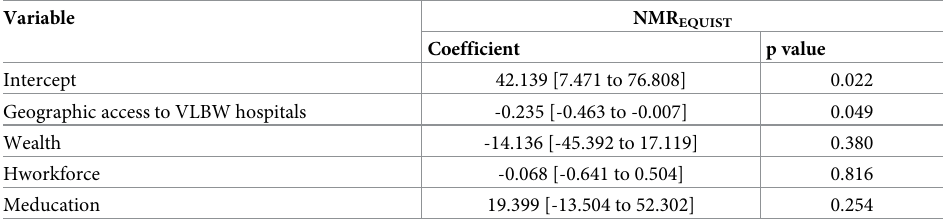
Table 2. Multivariable adjusted models of the relationship between access to VLBW and